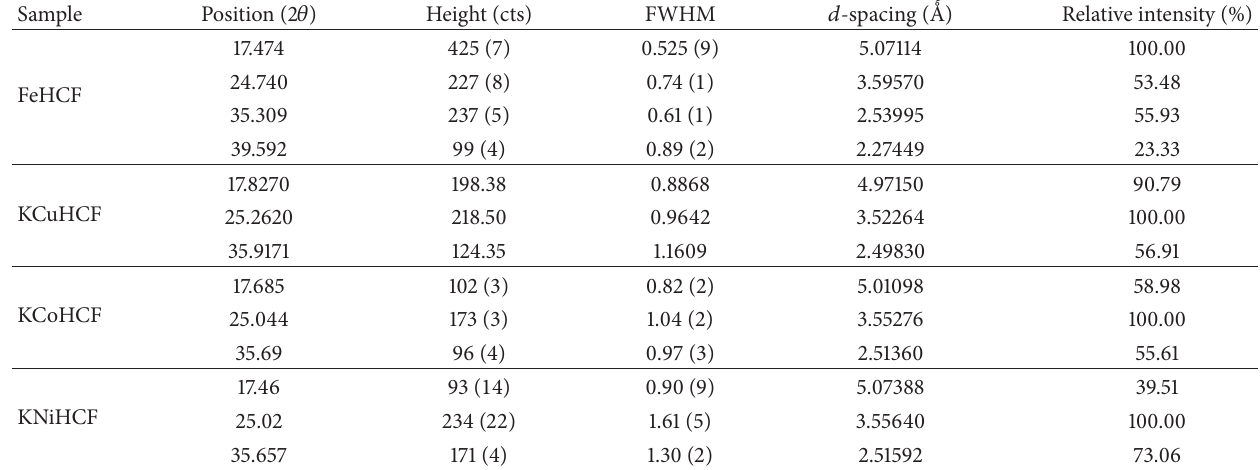
Table 1: PXRD parameters of FeHCF and other different KMHCF